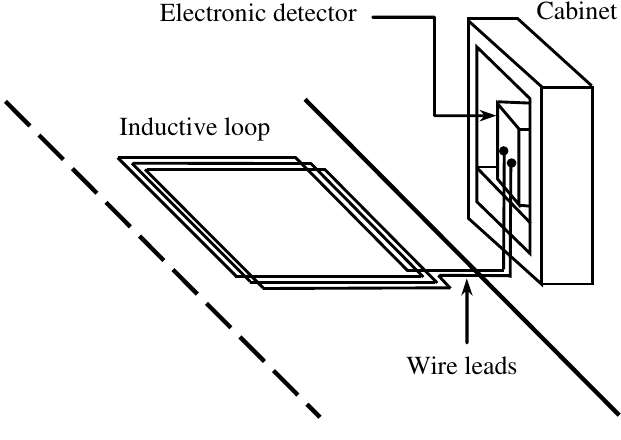
Figure 1. Elements of an inductive loop